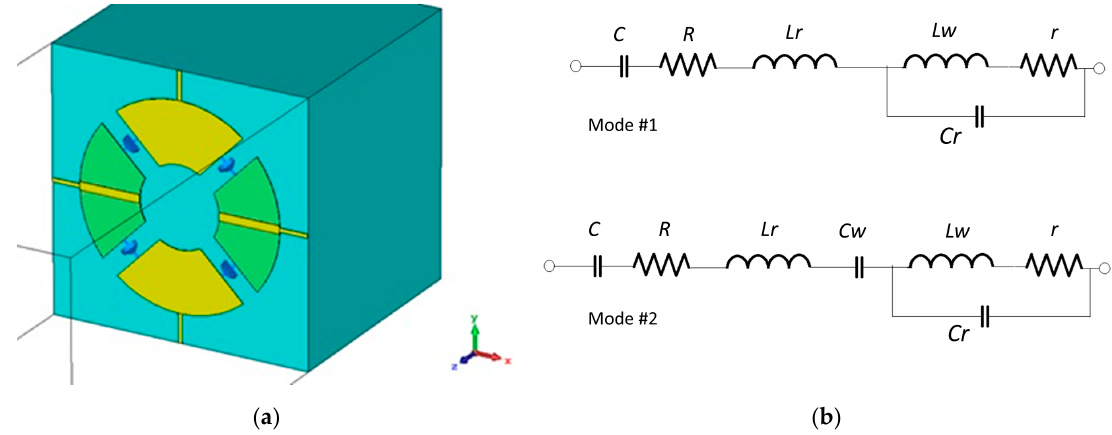
Figure 4. ( a ) Unit cell layout for dual mode sensing. ( b ) Equivalent circuits for Z FSS for two orthogonal modes of the Floquet port.